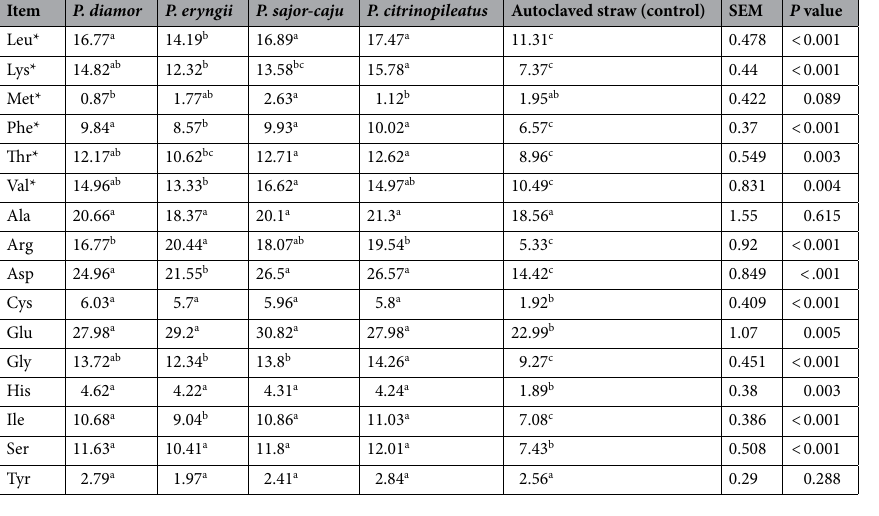
Table 3. Amino acid composition (mg/g) of corn stover after 21 days of incubation with various white rot fungi ( Pleurotus sp.) or control. *Means essential amino acid. SEM: standard error of mean. a–c Within a row, means without a common superscript differed ( P < 0.001).